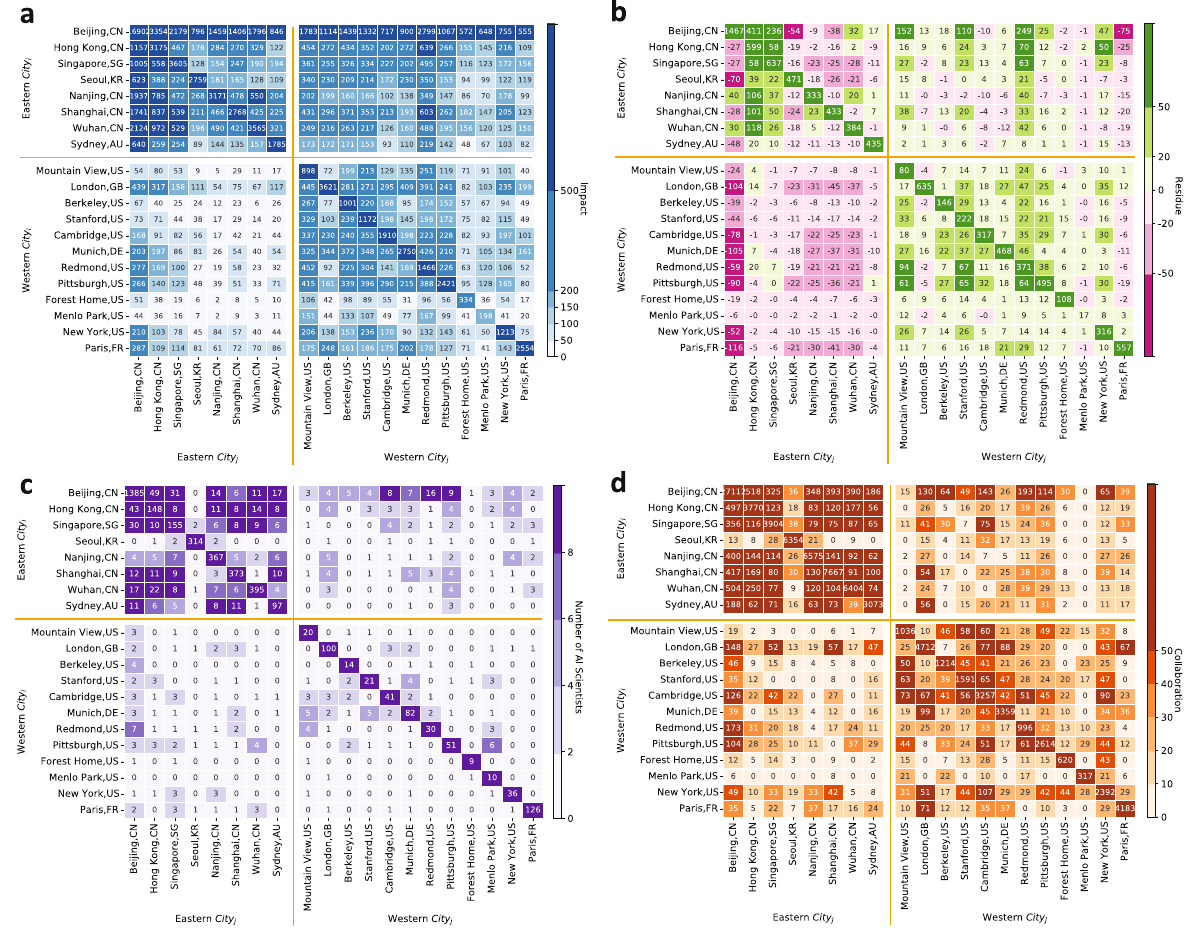
Figure 2. Pair-wise analysis of cities in terms of AI impact, AI over-impact, AI scientists’ migration, and AI scientists’ collaboration. All subfigures consider the same 20 cities, which were the most impactful in AI in 2017. ( a ) The value and color in each cell represent the number of citations from the row city, i , to the column city, j , in the five periods between 2013 and 2017. To compute this number, for every year y in [2013, 2017], and every paper p coming from city j in year y , we consider the citations that p received from papers in city i during the years y , y + 1 , and y + 2 . ( b ) Similar to ( a ) but after subtracting from each cell the expected number of citations according to our baseline model in which citations are random. ( c ) The cells that fall along the diagonal specify the number of scientists whose location in 2015 coincides with their location in 2019; every other cell specifies the number of AI scientists who relocated from the row city to the column city at any point in time during the five years between 2015 and 2019. ( d ) The value and color in each cell represent the number of collaborations from the row city, i , to the column city, j , in the 5-year period between 2015 and 2019, which is calculated as the number of papers in which the last author is in i and at least one coauthor is in j Fig. 4. As shown in this figure, there seems to be a divide between East and West, especially in the last few years, with certain venues being predominantly targeted by the East, and others being mostly targeted by the West. Figure 2a shows each of the top 20 cities’ impact over other cities during the five years between 2013 and 2017. The rows and columns are ordered such that Eastern cities are grouped together, and Western cities are grouped together. The value and color in each cell correspond to the number of citations from the row city to the column city (colors are binned to improve the visualization; an alternative coloring scheme is provided in Supplementary Fig. 5). It should be noted that impact flows in the opposite direction of citations. For example, a city j impacts another city i when i cites j . Thus, in this heatmap, each cell reflects the impact of the column city over the row city, not the other way around. Figure 2a reveals three salient patterns. First, Eastern cities feature little impact on Western cities (see how the color intensity in the bottom-left quadrant is much lower than that of the remaining quadrants). Among Eastern cities, however, Beijing shows the greatest aggregate impact on Western cities; an aggregate impact comparable to that of Berkeley or Cambridge U.S. (without counting the impact that each of the latter cities exerts on itself). Second, Beijing cites all other top cities massively (notice the color intensity of the first row, which is higher than that of any other row). Excluding itself, about 45% of Beijing’s citations are to Eastern cities, and 55% are to Western ones, suggesting that the city’s research builds on knowl- edge produced across the globe. Third, each city cites itself heavily (see how the color intensity is exceptionally